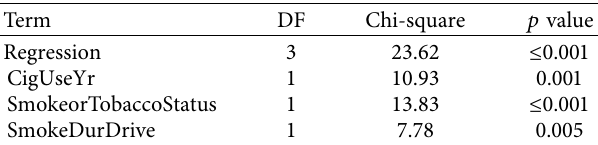
∗ Odds ratio for level A relative to level B. Table 11: Wald test of the new regression model. Term